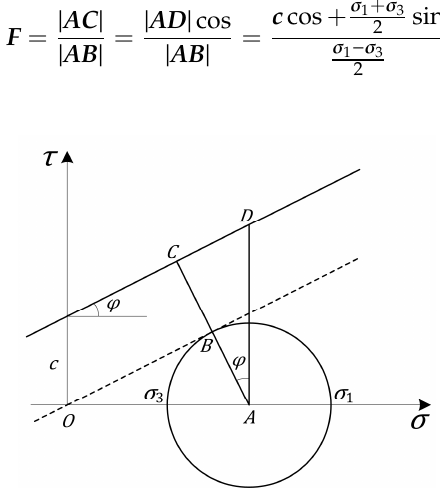
Figure 2. Point safety factor based on Mohr–Coulomb criterion.